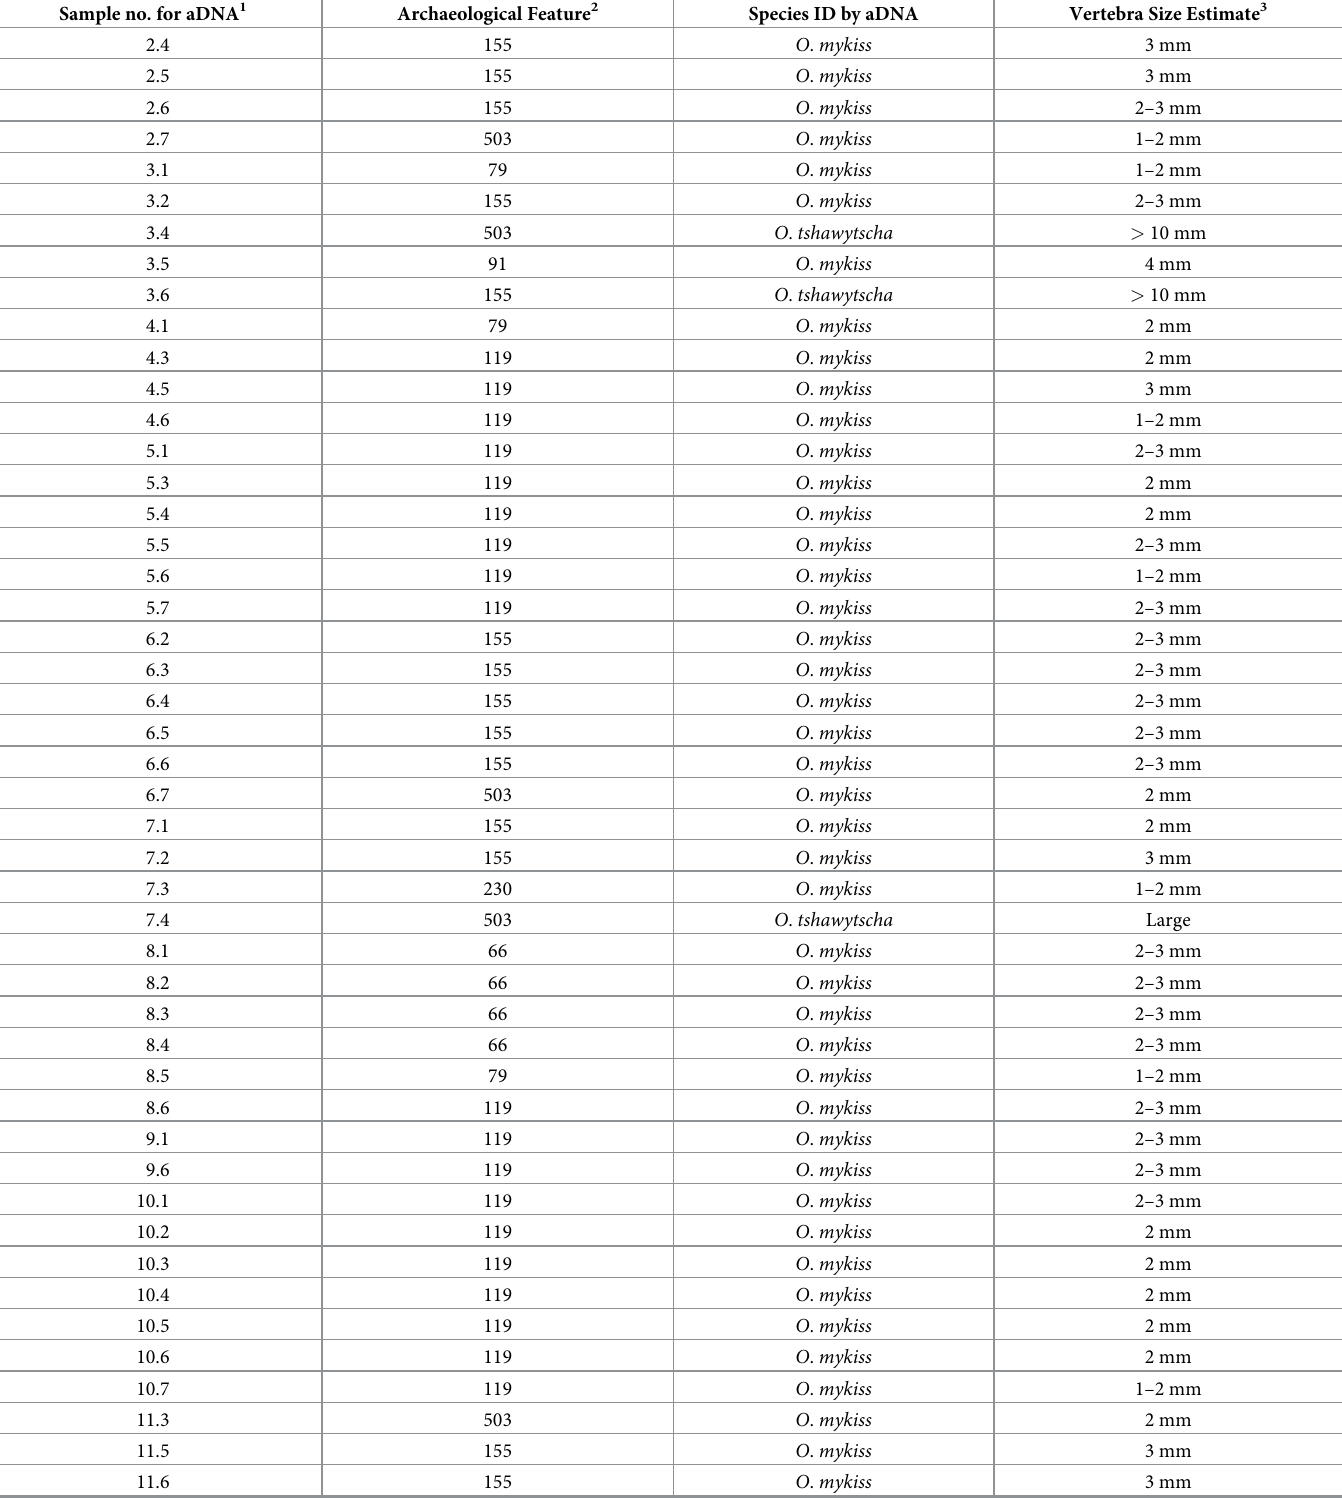
Table 2. Species, archaeological context, and estimated vertebral centrum diameter for 58 salmonid vertebrae that produced aDNA results. Sample no. for aDNA